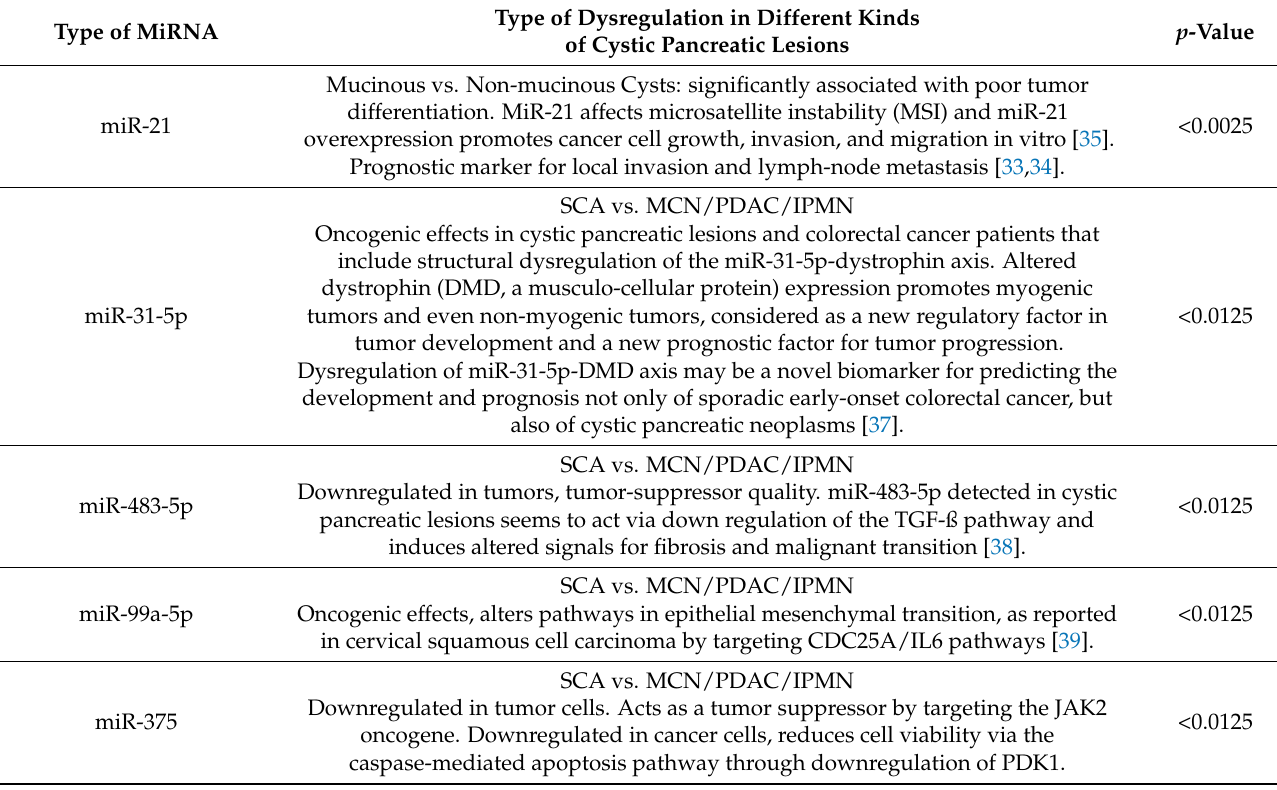
Table 2. MiRNA expression in pancreatic cysts and malignant pancreatic tissue. Comparison of dysregulation is shown in cysts or premalignant vs. malignant tissue. Relevant p -values for discrimination are presented between different entities and outlined depending on the significance levels (see References